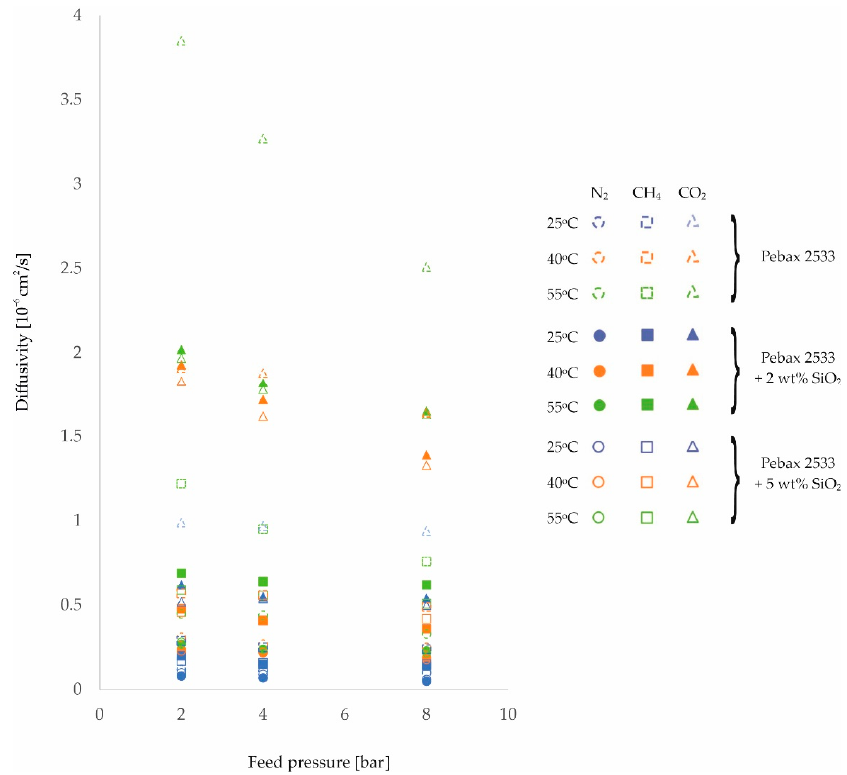
Figure 4. Change in diffusion coefficient values of homogeneous membrane and heterogeneous membranes containing SiO 2 for different feed pressure and temperature values.